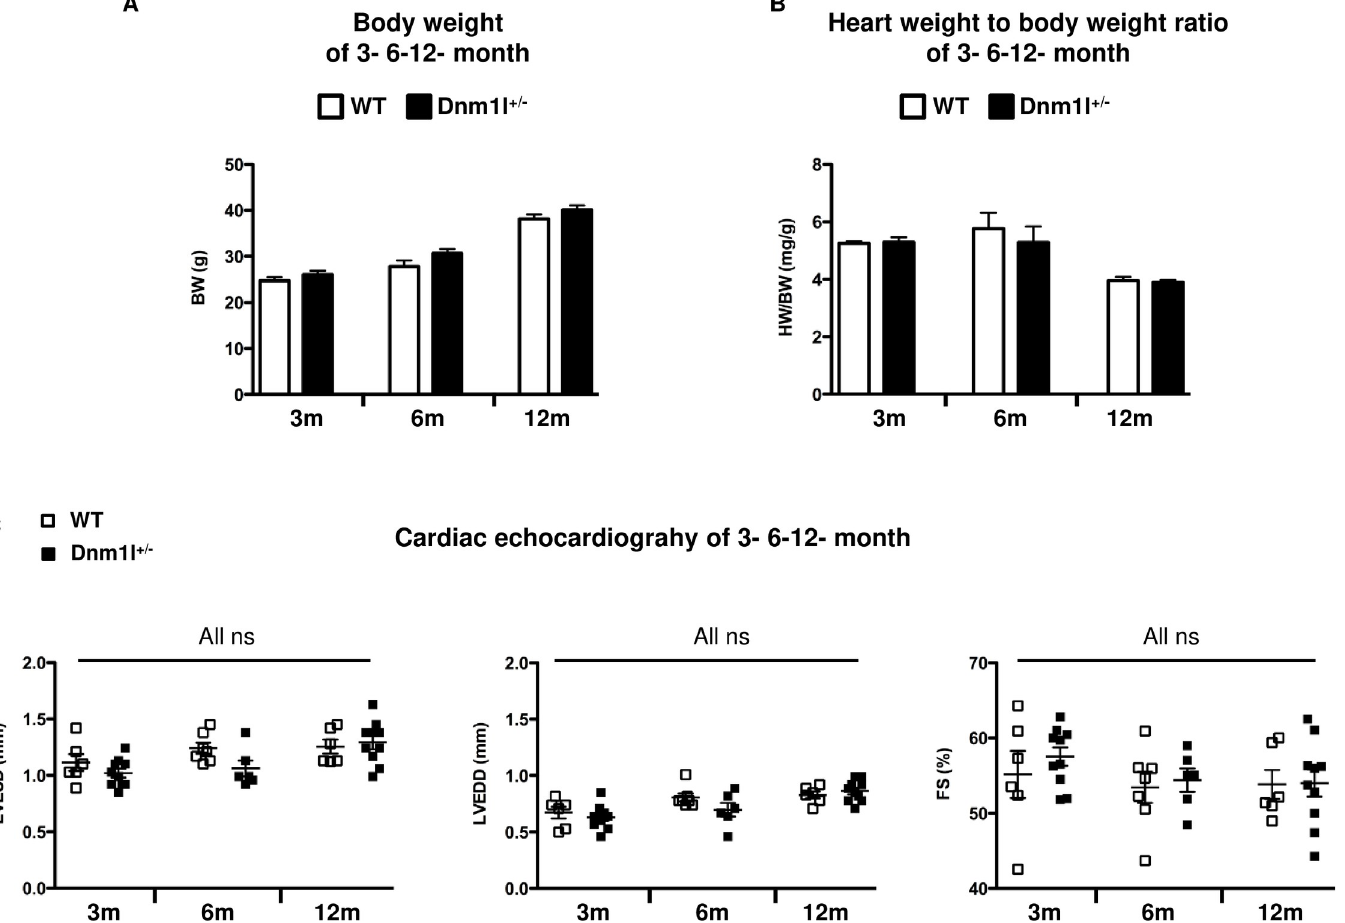
Fig 1. Anatomical characteristics and heart function of 3-, 6- and 12-month-old Dnm1l+/- and their wild type littermate (WT) mice. (A) Body weight (BW). (B) Heart weight to body weight (HW/BW) ratio. (C) Cardiac echocardiography, left: Left ventricle end-systolic volume (LVESD), middle: LV end-diastolic volume (LVEDD), right: LV fractional shortening (FS). Three months: n = 6–10 WT and n = 10 Dnm1l +/- ; 6 months: n = 7–10 WT and n = 6–8 Dnm1l +/- ; 12 months: n = 6–8 WT and n = 10 Dnm1l +/-